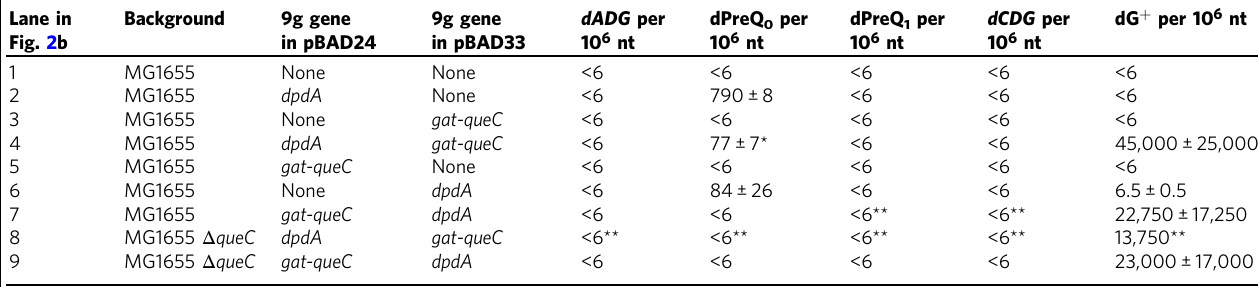
Table 1 DNA modi fi cations identi fi ed by mass spectrometry in the plasmids shown Fig. 2b. Lane in Fig.